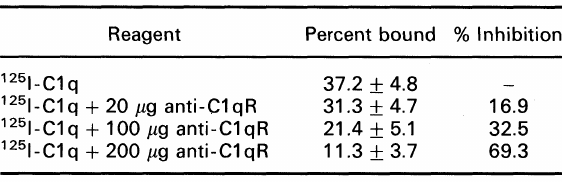
Table 3. Inhibition of binding of 1251-Clq to endothelial cells by F(ab’)2